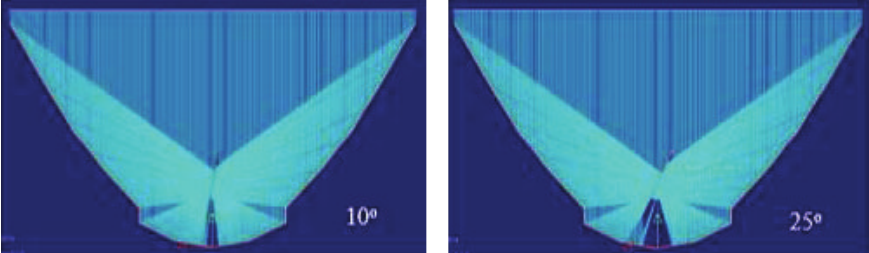
Figure 5: Optical simulation results when receiving plate is not coincidence with the symmetry axis of concentrator.